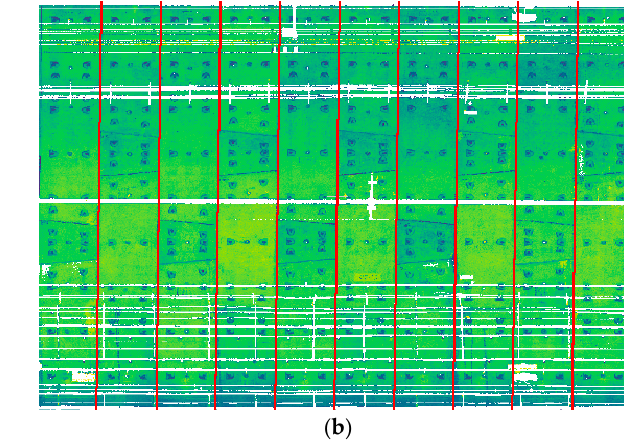
Figure 10. ( a ) Straight-line fitting effect and ( b ) positioning effect of circumferential seams between rings.